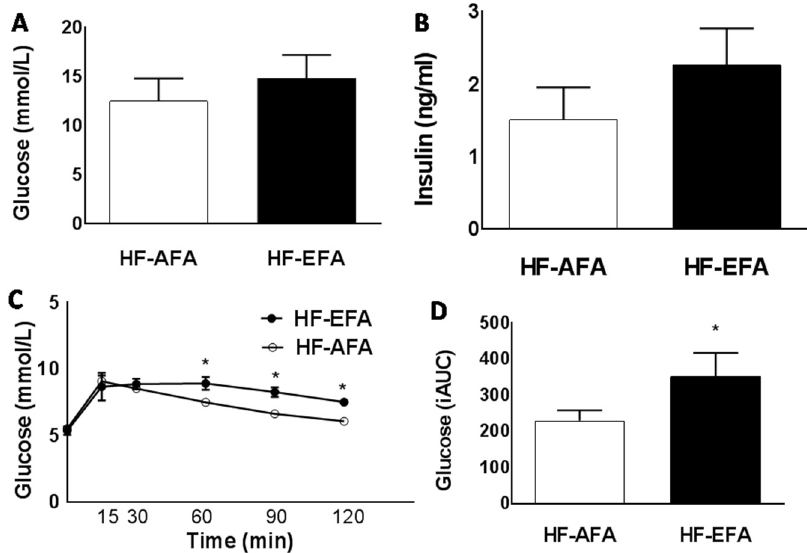
Figure 3. Excess folic acid intake impairs glucose tolerance on a high fat diet. ( A ) Fasting plasma glucose; ( B ) fasting plasma insulin; ( C ) blood glucose concentrations at different time points (15, 30, 60, 90, 120 min) after an intraperitoneal (IP) glucose injection; and ( D ) area under the glucose curve, for male rats fed 60% HF diet with excess or adequate folic acid. Values are means ± SEM, * p < 0.05.